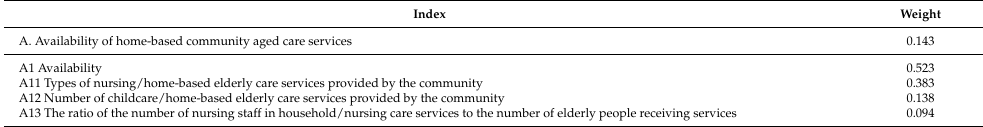
Table A1. Evaluation Index System for Basic Old-Age Care Services in Districts and Counties.